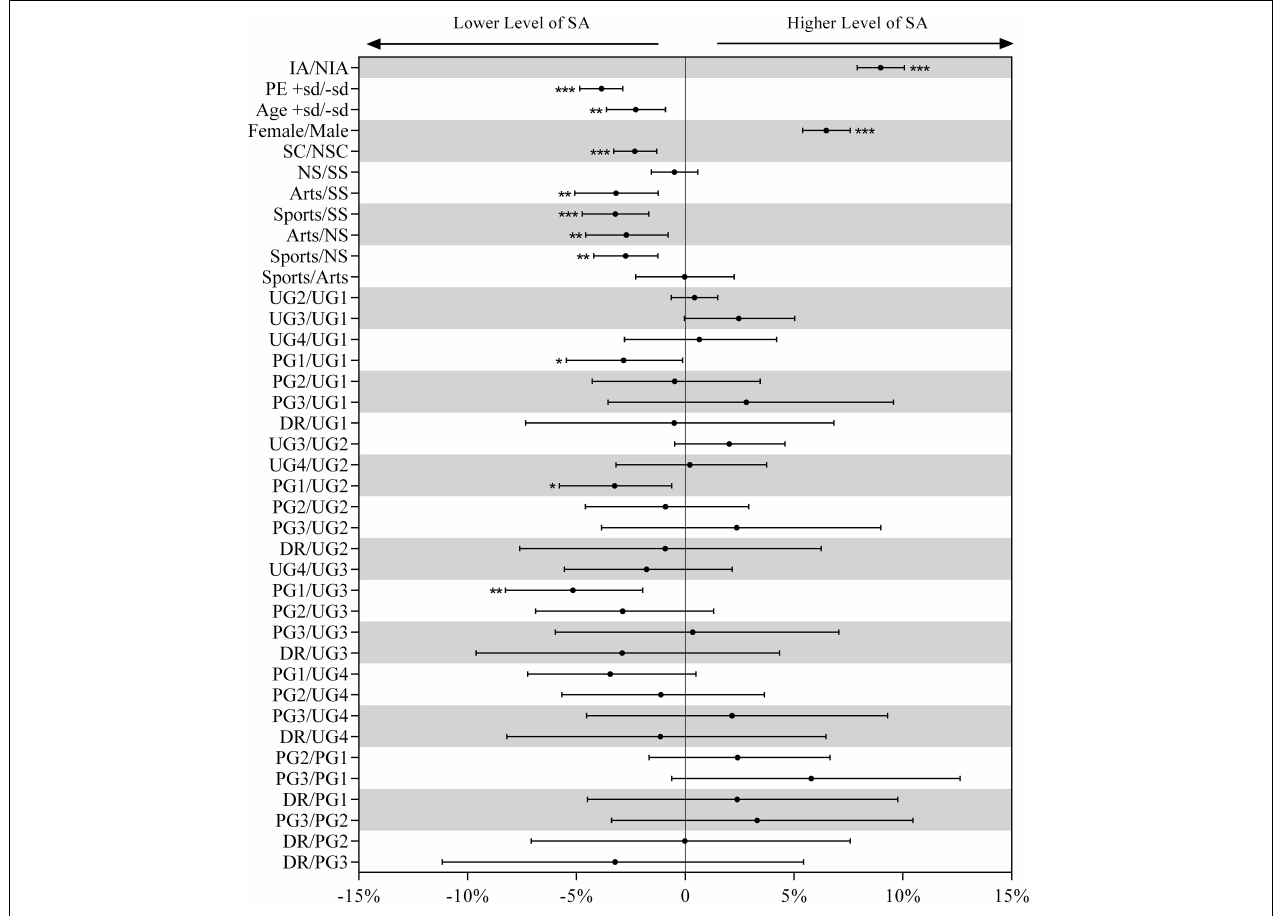
FIGURE 2 | Effects of SA, PE, age, gender, single child, major, and grade on the IA estimated from the binomial logistic regression. Dots are the estimated difference in the probability of IA, and error bars are their 95% compatibility intervals. Asterisks indicate the significance level as follows: * p < 0.05, ** p < 0.01, *** p < 0.001. IA, internet addiction; PE, physical exercise; SA, social anxiety; SC, single child; NSC, non-single child; SS, social science; NS, natural science; UG1-UG4, 1st–4th year of undergraduate; PG1-PG3, 1st–3rd year of postgraduate; DR,